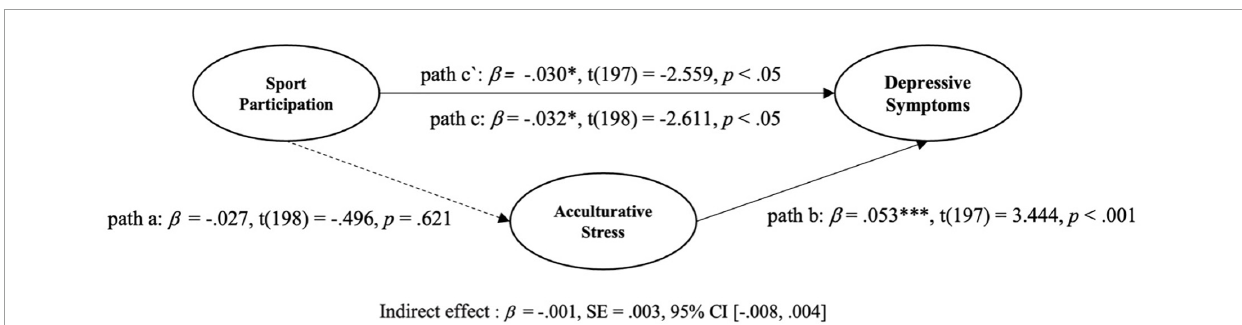
FIGURE1 Integrative framework of acculturation and salutogenesis (32).